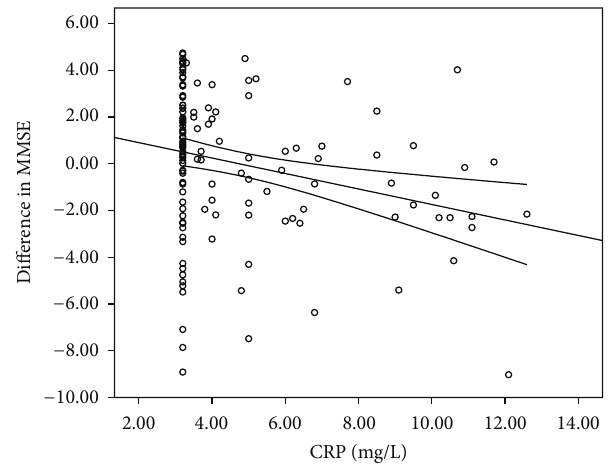
Figure 2: Linear regression showing the relationship between Δ MMSE and CRP levels (mg/L) (𝑃 < 0.001) . CRP: C-reactive protein; MMSE: Mini Mental Status Examination.